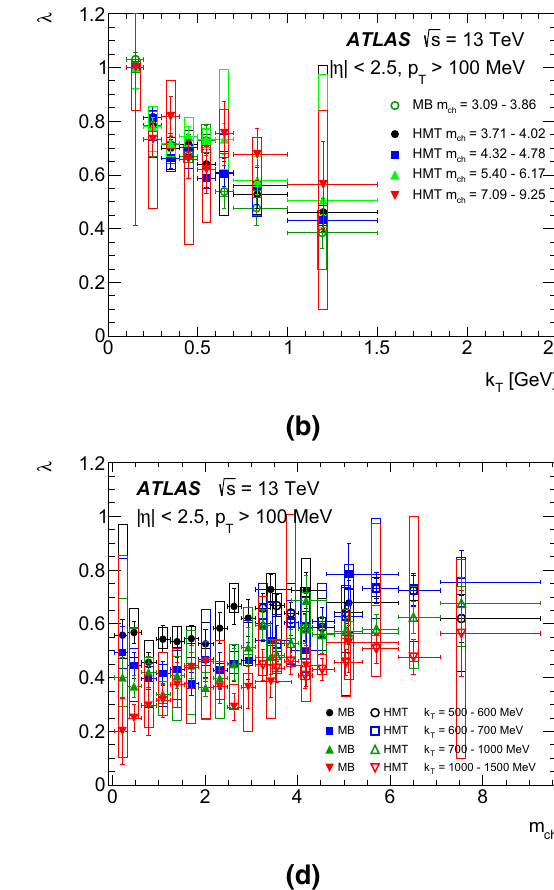
and d as a function of m ch in k T intervals between 0.5 and 1.5 GeV. The error bars and boxes represent the statistical and systematic